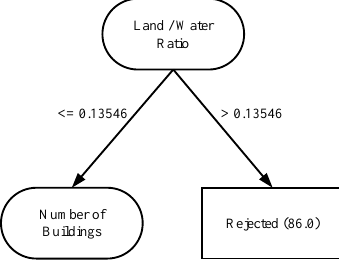
Figure 13. Decision tree